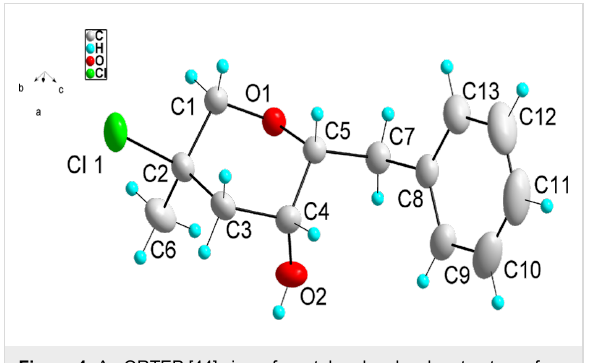
Figure 4: An ORTEP [44] view of crystal and molecular structure of 53